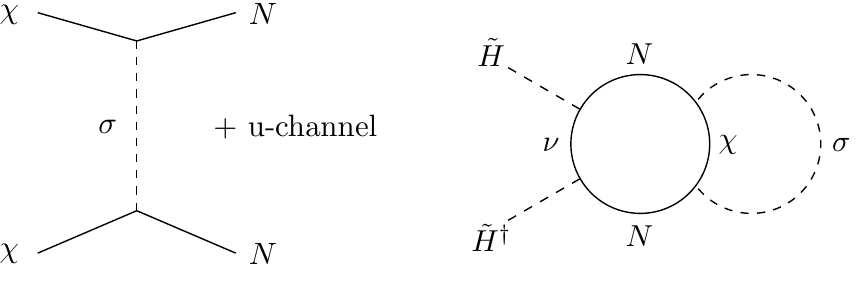
Figure 4 . Feynman diagramms for the scattering process χχ ↔ NN (left) and two-loop contribu- tion to the Higgs mass term